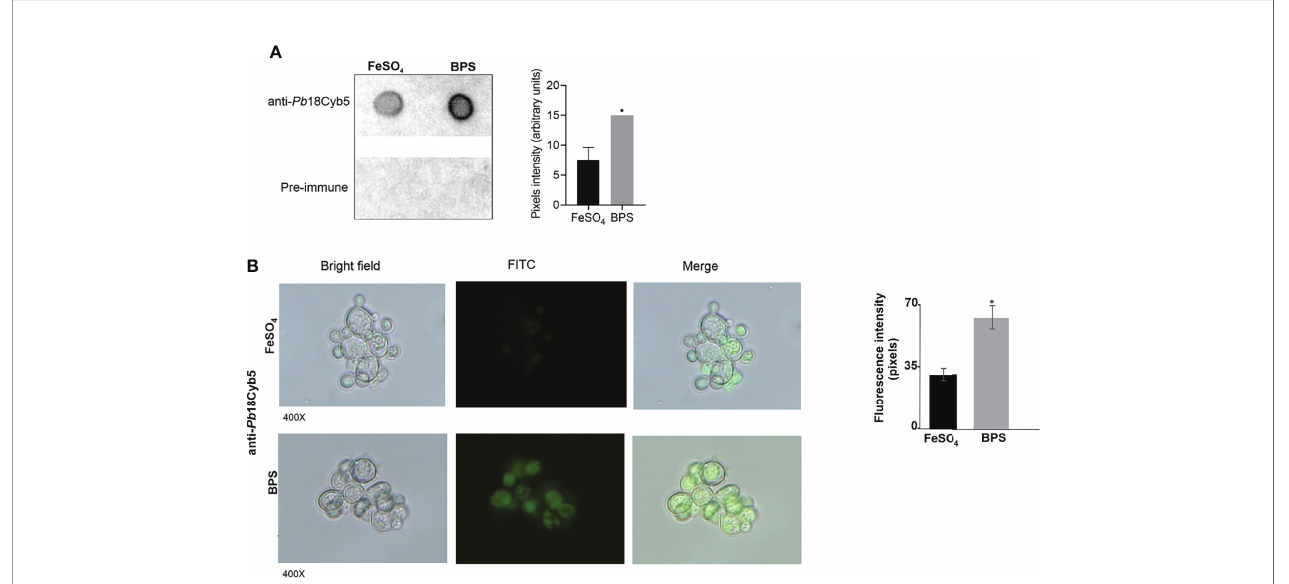
FIGURE 3 | Analyzing the expression dynamics of Paracoccidioides Cyb5 in iron deprivation. (A) Dot-blot analysis. Nitrocellulose membranes containing exoproteomes (FeSO 4 and BPS) were incubated with anti- Pb 18Cyb5 (1:500) polyclonal antibodies or pre-immune sera (1:1,000). Pixel intensity was measured by densitometric analysis of immunoblotting dots using ImageJ software. Statistics analysis was performed through Student ’ s t-test. * Represents p ≤ 0.05. (B) Fluorescence microscopy of P. brasiliensis ( Pb 18) cells cultured in the presence or absence of iron for 24 h and subsequently incubated with primary antibody anti-Cyb5 and later with the secondary antibody anti-mouse IgG labeled with fl uorescein isothiocyanate (FITC; Sigma). The data for fl uorescence intensity evaluation were obtained through the AxioVision Software (Carl Zeiss). The values of fl uorescence intensity (in pixels) and the standard error of each analysis were used to plot the graph. Data are expressed as mean ± standard error (represented using error bars); * represents p ≤ 0.05. One hundred cells of each condition were evaluated. All representative images in panel B were magni fi ed